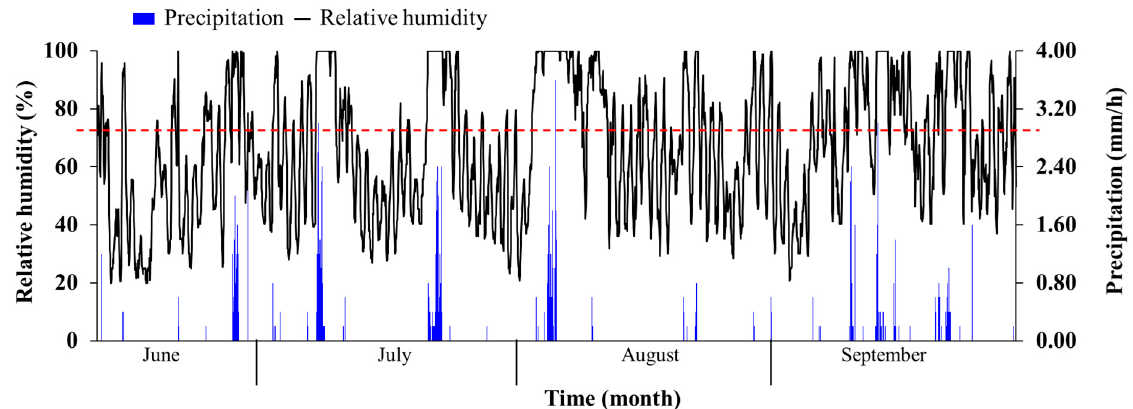
Figure 9. The distribution of relative humidity in the growing season of Tamarisk, 2020. Table 3. Precipitation, growing season, and high humidity duration in